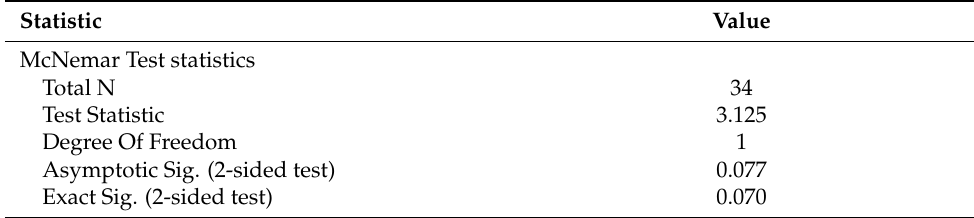
Table 8. Related-samples McNemar change test.